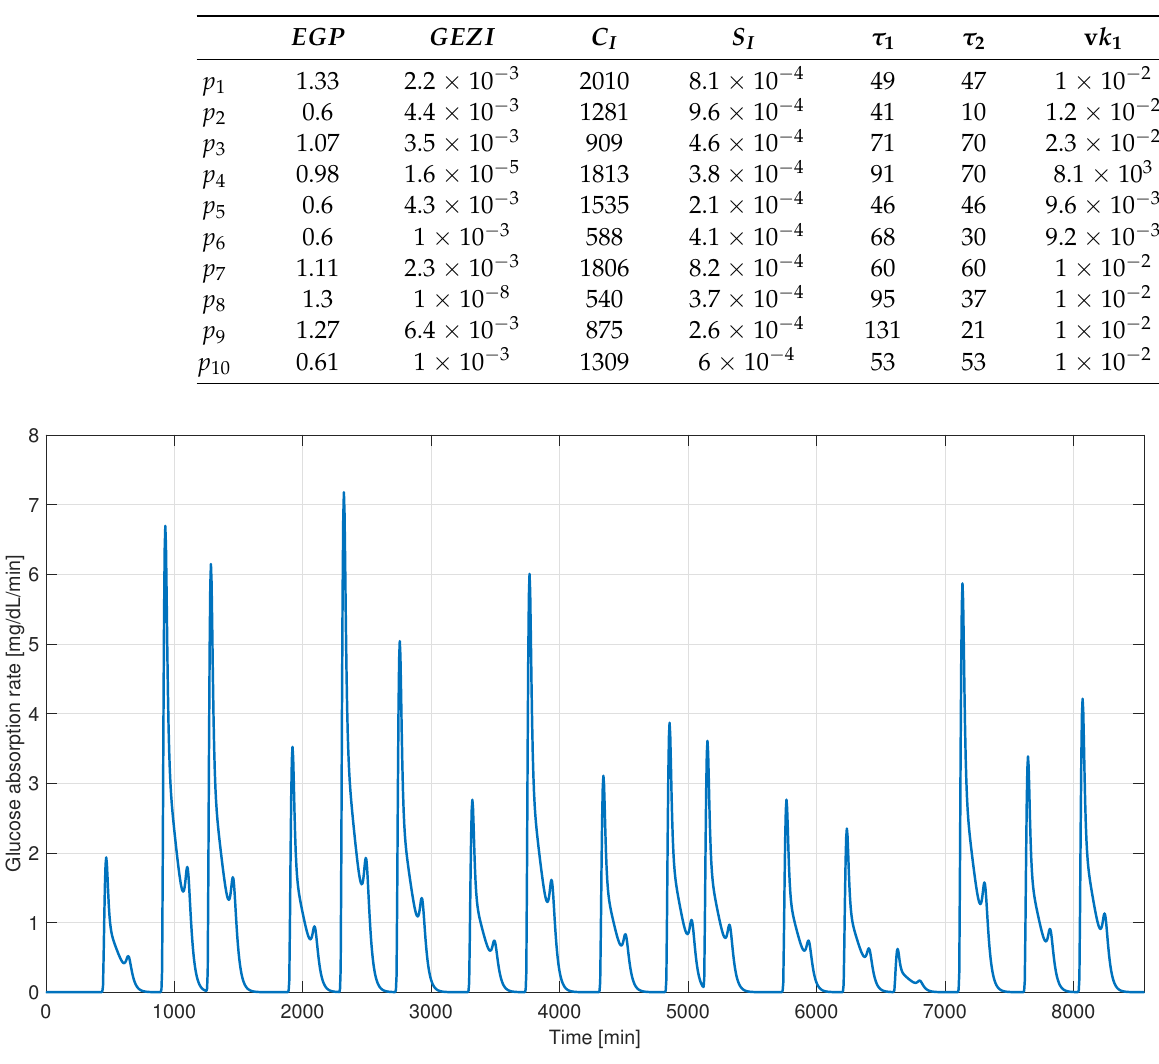
Figure 2. Rate of glucose appearance after CH absorption for the